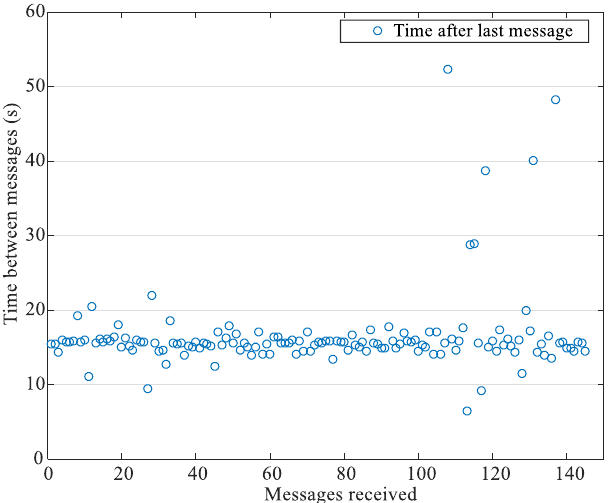
Figure 17. Time difference between the received messages.